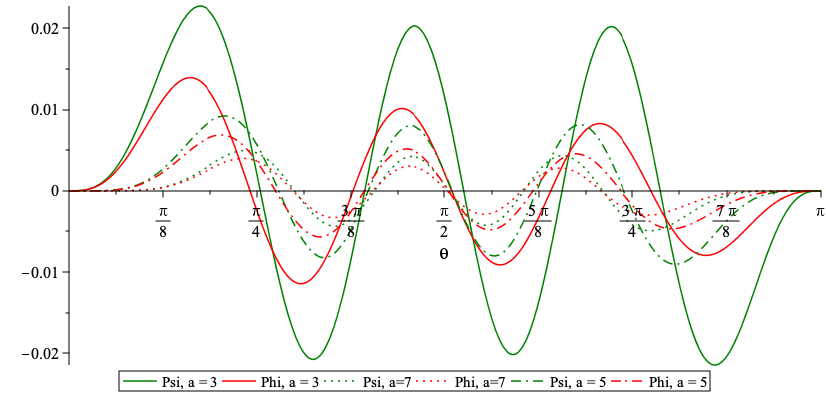
Figure 1. Ψ n ( θ ; a , b ) in green and Φ n ( θ ; a , b ) in red with n = 5, b = 1 and a = 3,5,7.